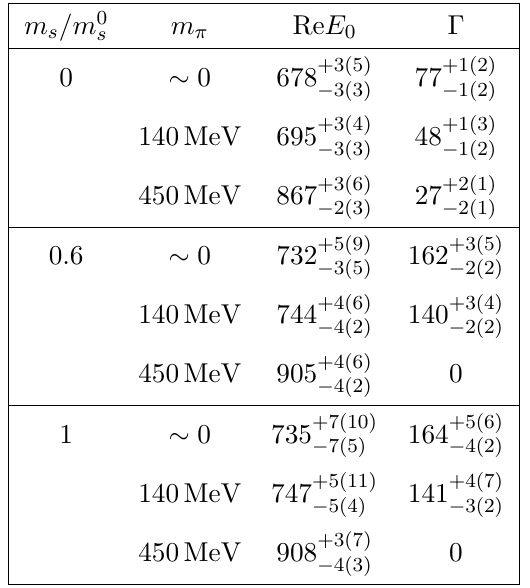
Figure 29 . The real and imaginary parts of the (cid:26) -meson pole position as a function of m K over the m u = c and m (cid:25) = m 0 trajectories. (cid:25)